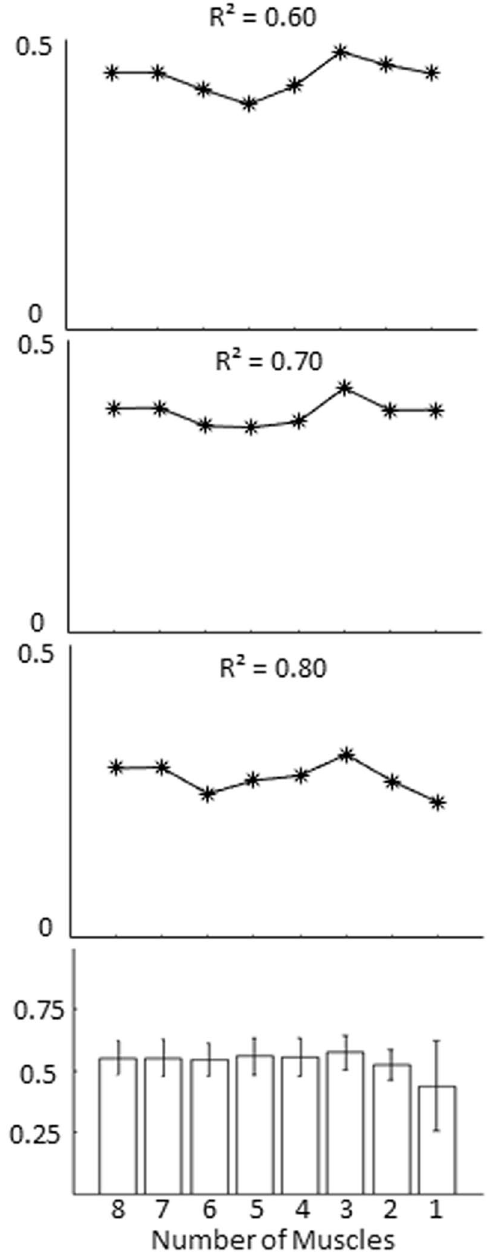
Figure 5. Best MCM curve. From top to bottom, the first three plots show the likelihood ( L (R² | Number of Muscles) of the MCM curve’s ability to provide 60% to 80% of explained perceptual variance (pseudo-R²) as a function of the number of muscles (1 to 8). The bottom plot shows the median ± SE of across-participants pseudo- R² . The likelihood of the variance accounted for by each MCM was obtained through an iterative multiple regression with a backward elimination procedure where, at each iteration, the least contributive muscle was excluded from the model (for details see The most contributive model , Methods). This analysis shows that the MCM composed of three muscles is always the most likely to explain approximately 60% (or higher) total perceptual